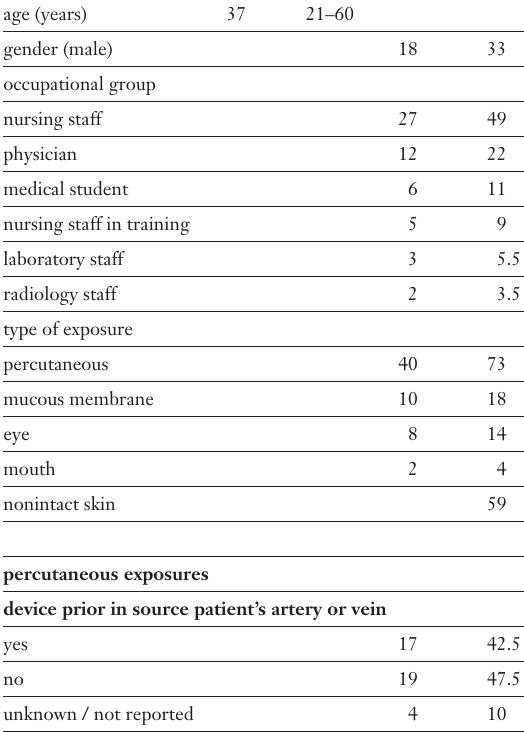
Table 1 Demographics of health care workers (HCWs), description of exposures, and self-perceived HIV transmission risk by HCWs (n =